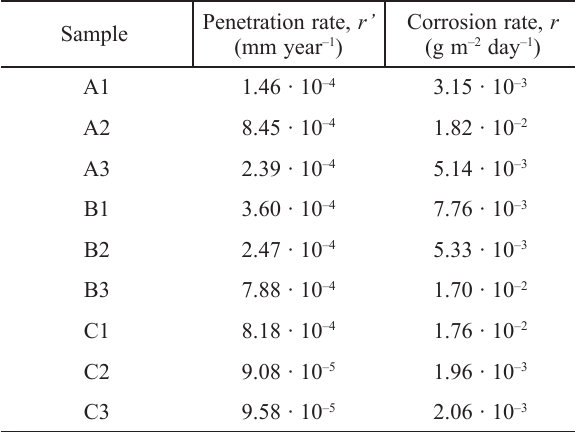
Table 3 – Calculated penetration and corrosion rates of gas- oline from different automotive fuel retail brands